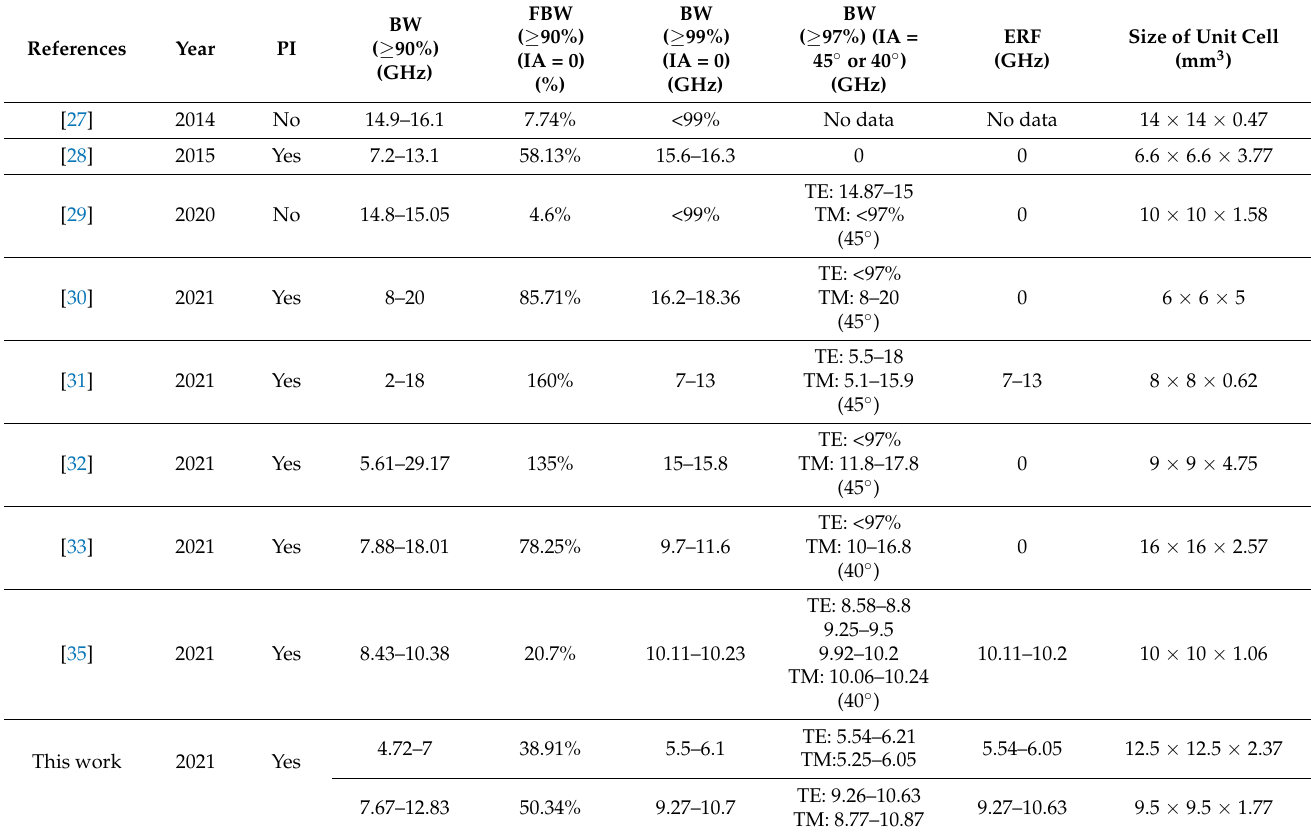
Table 1. Comparison of the performance of our MA with relevant